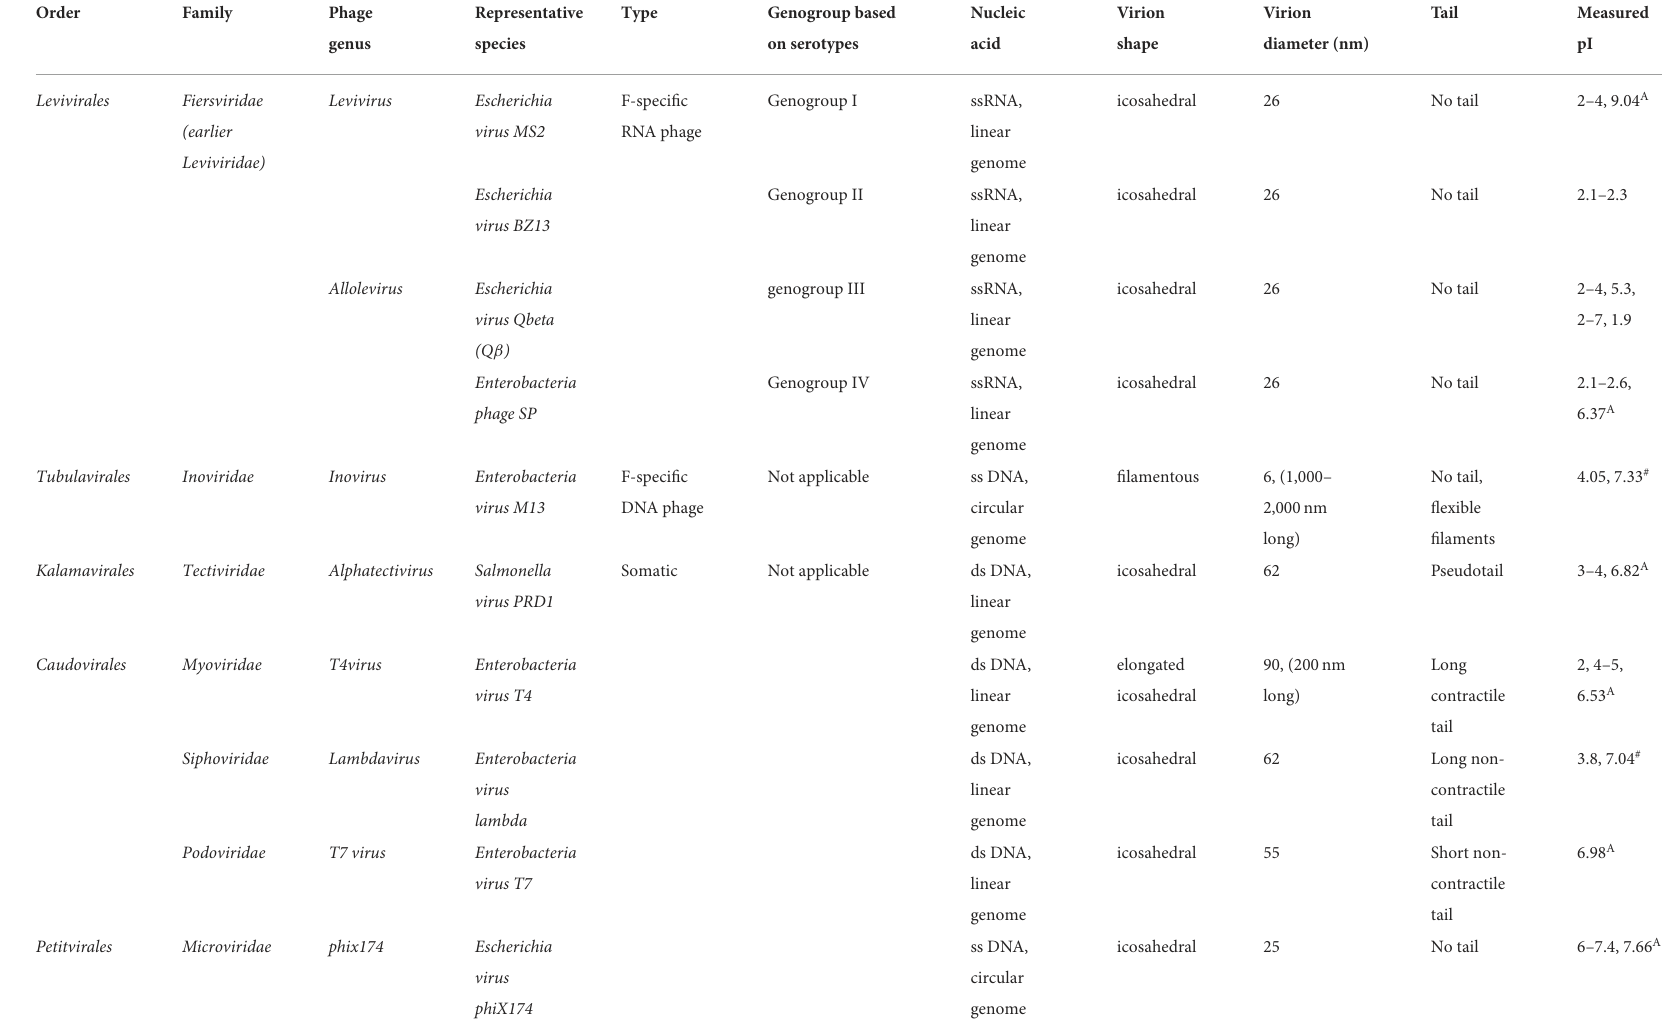
TABLE 1 Characteristics of major groups of bacteriophages and their representative phage